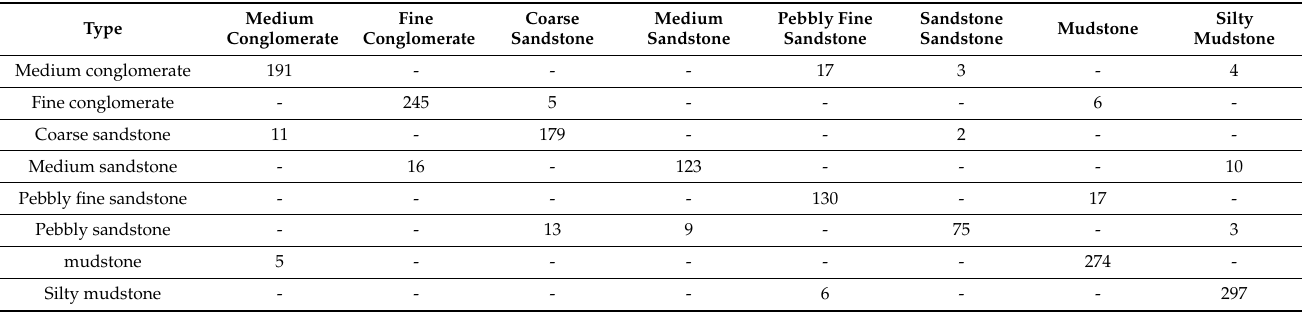
Table 1. Lithology prediction results of SVM algorithm.